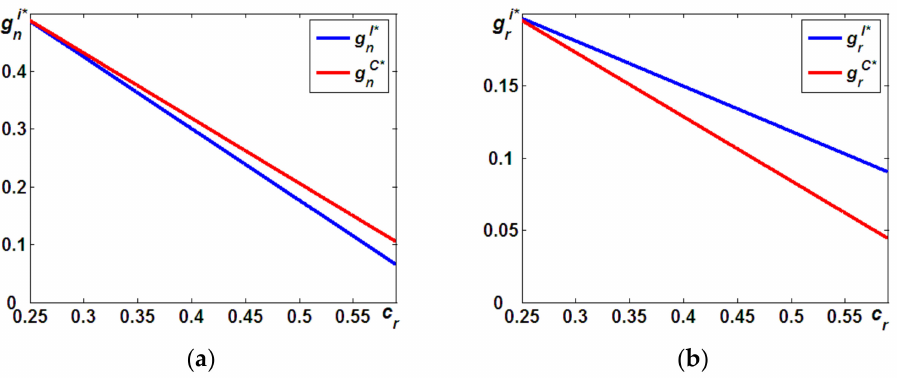
Figure 6. Differences in incentives for carbon emission reduction. (a) g I ∗ n vs. g C ∗ n ; (b) g I ∗ r vs. g C ∗ r